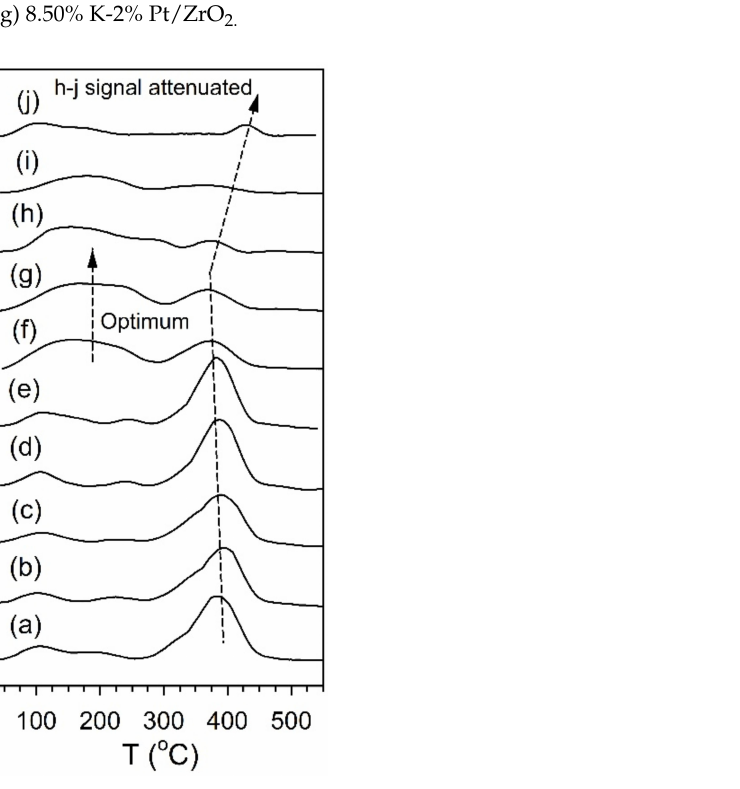
Figure 13. TPD-MS of ethanol steam reforming over (a) 2% Pt/ZrO 2 , (b) 0.37% Rb-2% Pt/ZrO 2 , (c) 0.74% Rb-2% Pt/ZrO 2 , (d) 0.93% Rb-2% Pt/ZrO 2 , (e) 1.86% Rb-2% Pt/ZrO 2 , (f) 2.79% Rb-2% Pt/ZrO 2 , (g) 3.72% Rb-2% Pt/ZrO 2, (h) 4.65% Rb-2% Pt/ZrO 2 , (i) 5.58% Rb-2% Pt/ZrO 2 , (j) 9.29% Rb-2% Pt-ZrO 2